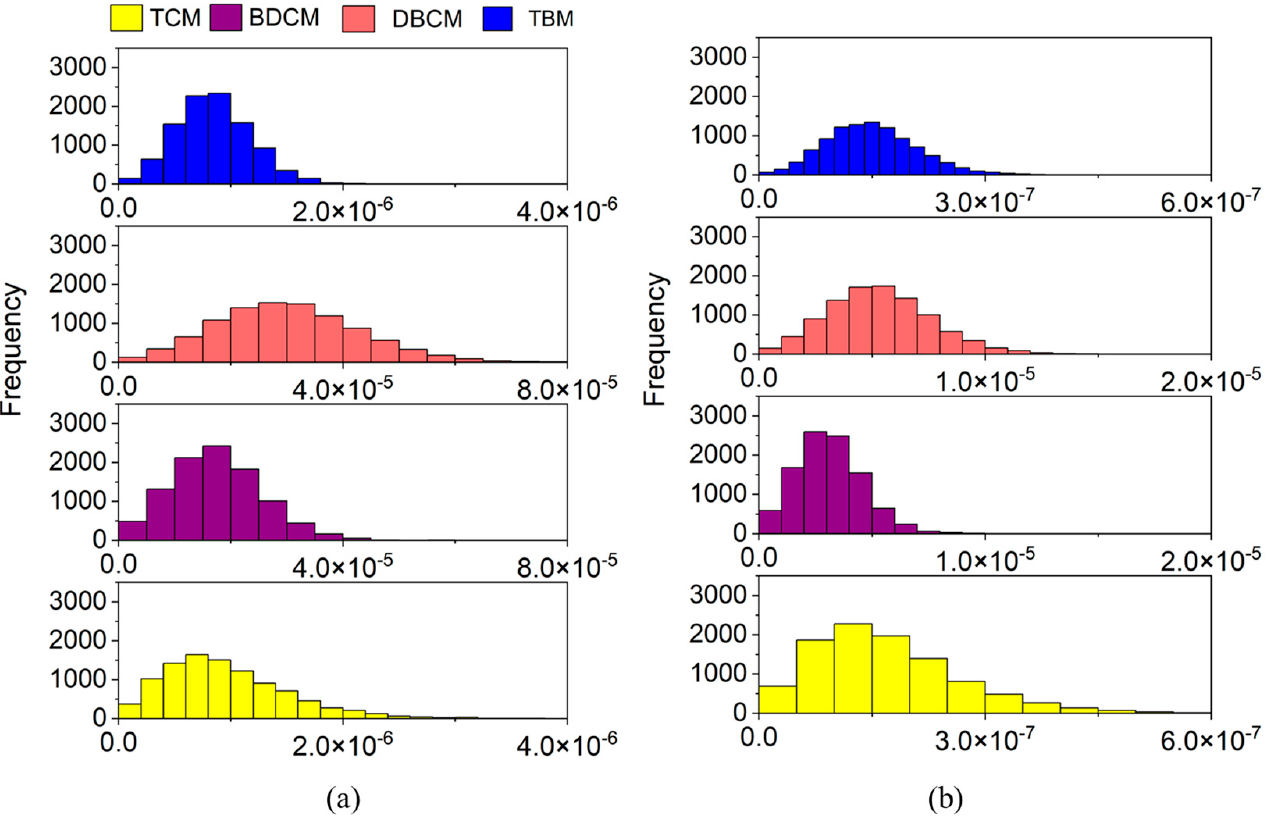
Figure 3. Frequency distribution of cancer risk of THM through ( a ) ingestion and ( b ) dermal con- tact. TCM: trichloromethane, BDCM: bromodichloromethane, DBCM: dibromochloromethane, and TBM: tribromomethane.